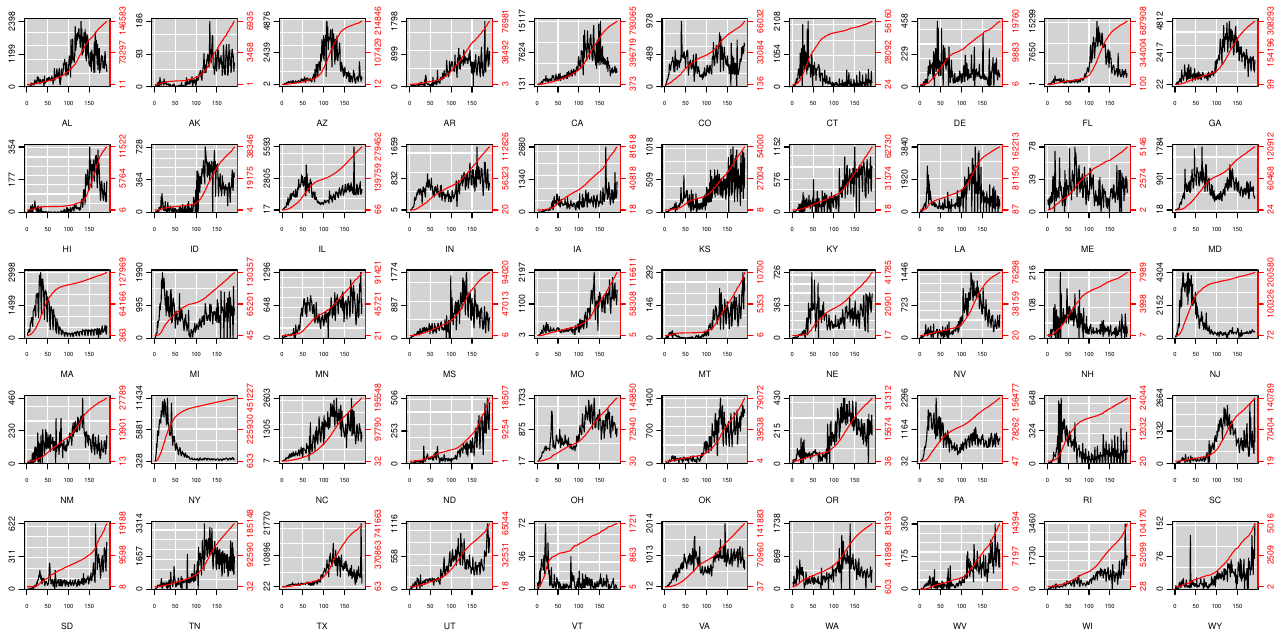
Figure 1. Original data of state-level daily positive test cases in the USA from https://www.kaggle.com/sudalairajkumar/ covid19-in-usa (excluding Washington, D.C.). The black line indicates the related daily confirmed cases and the red line the cumulative confirmed cases. The names of all states are denoted by the related postal codes.